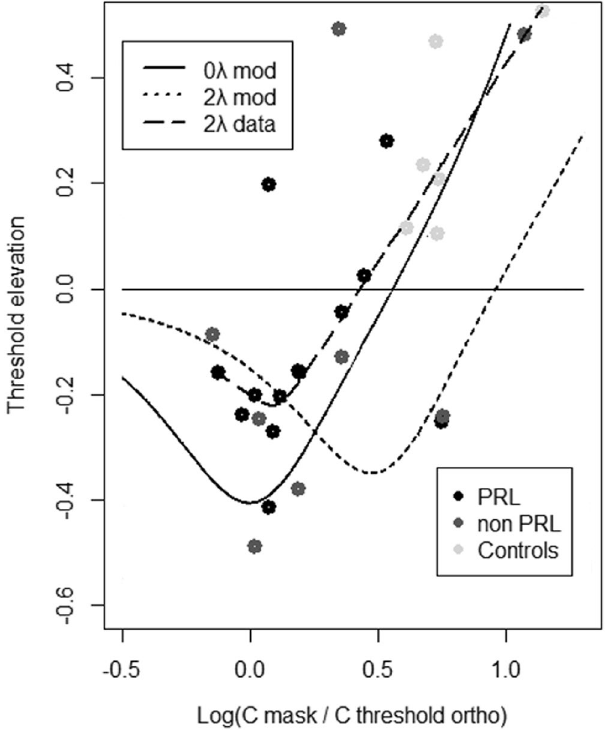
Figure 7. TEs as a function of log 10 (Contrast flankers /Contrast target threshold ) in the 8 λ orthogonal condition are shown for the pooled data obtained by patients at the PRL (n = 13) and at the non-PRL (n = 8), and for the data of the control group (N = 7). Prediction for the 0 λ and 2 λ based on the model from Zenger and Sagi (1996) are shown together with the locally weighted scatterplot smoothing (lowess) from our